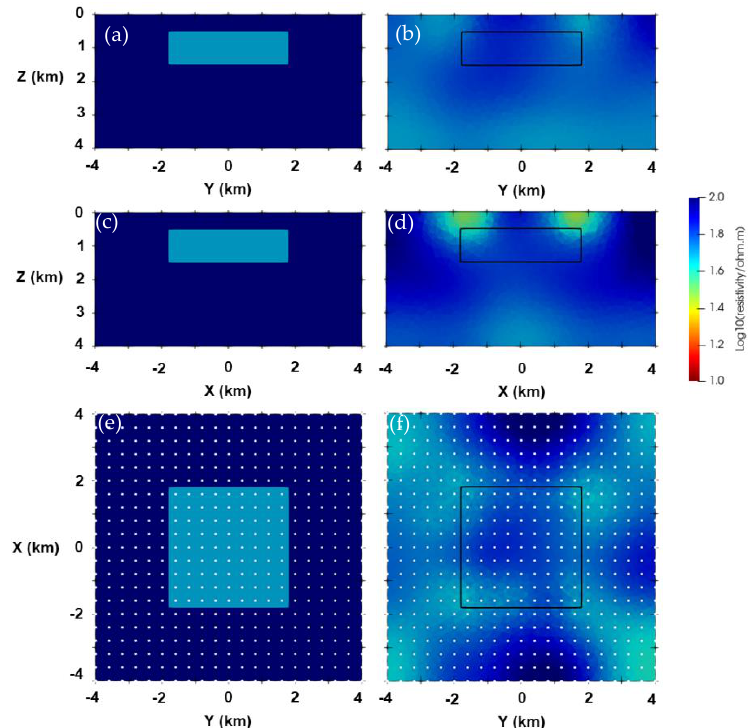
Figure 6. The inverted principal conductivity along the Y-axis. Panels ( a ) and ( b ) show the true model and recovered model at x = 0 km. Panels ( c ) and ( d ) show the true model and recovered model at y = 0 km. Panels ( e ) and ( f ) show the true model and the recovered model at z = 1 km.